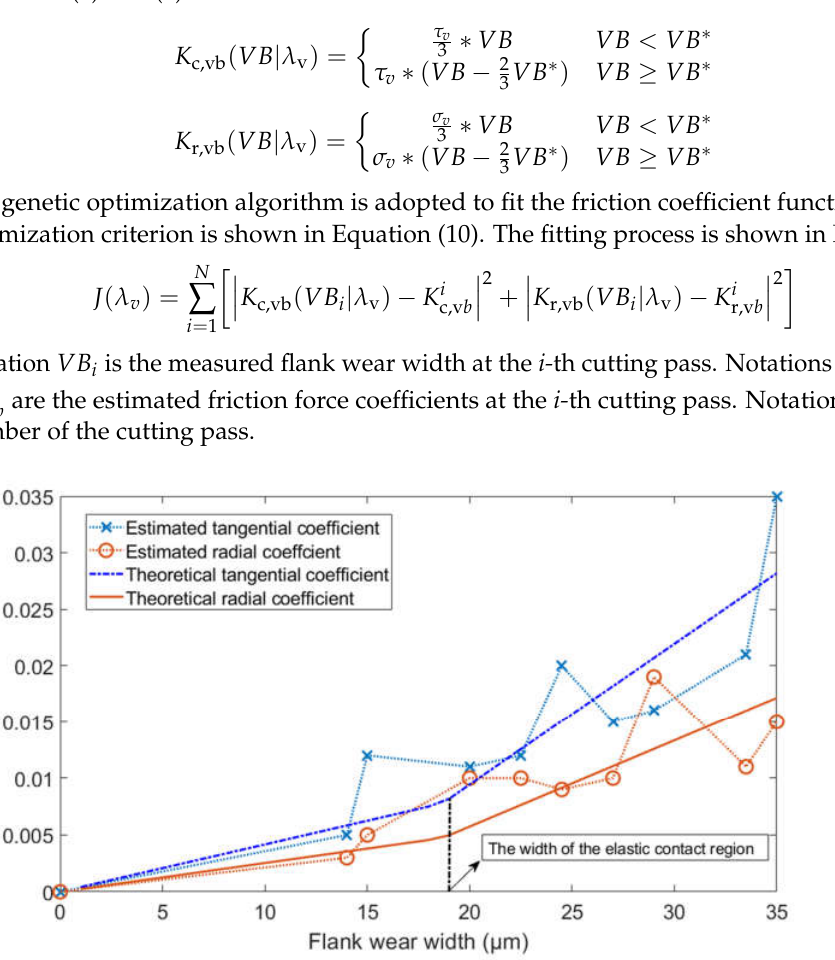
Figure 3. The fitting of the friction force coefficient function.